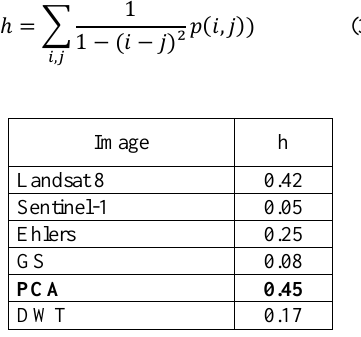
Table 4. Homogeneity measurements of the image fusion